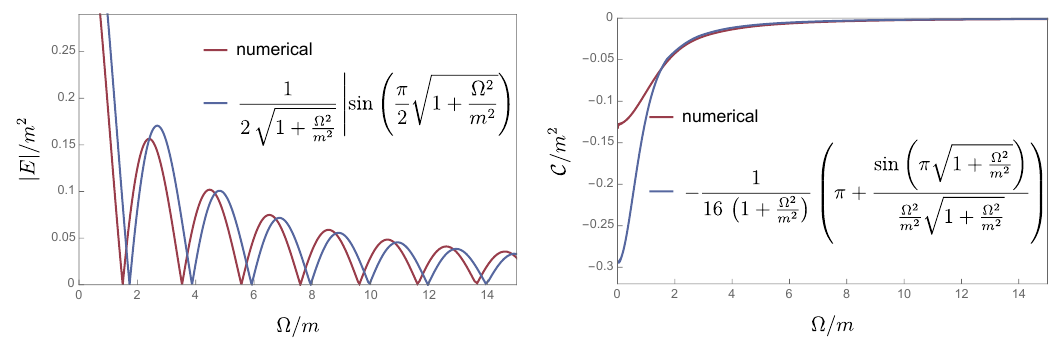
, using z 2 = 1 . 2 1+ (cid:26) 2